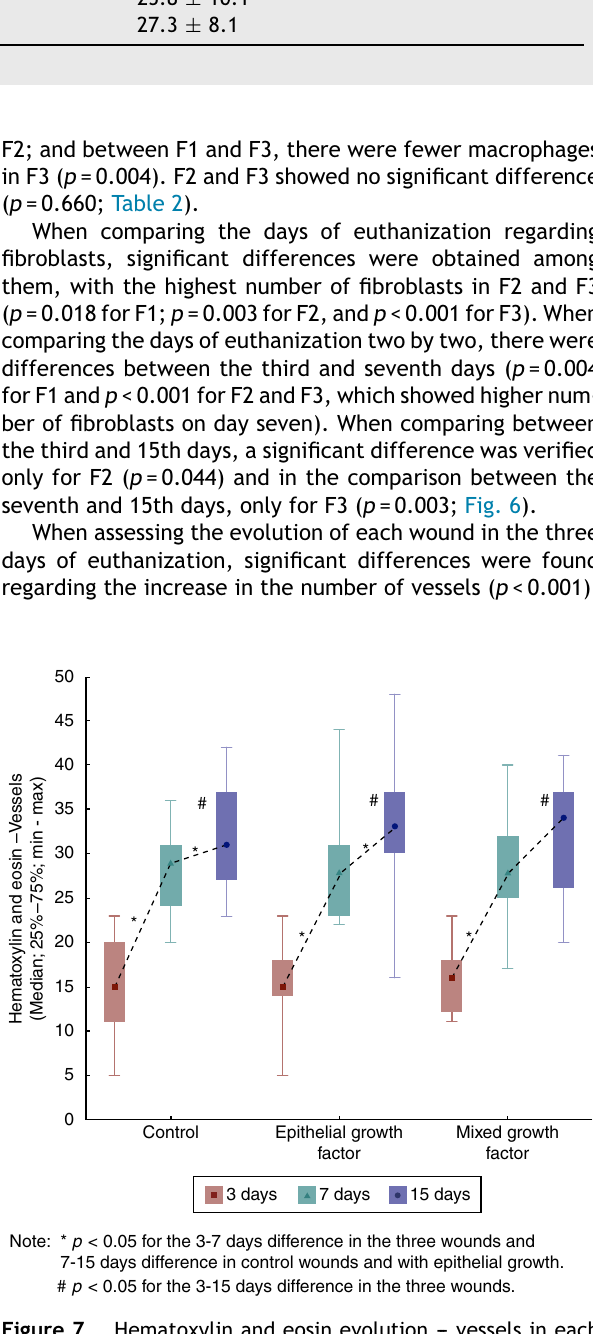
Hematoxylin and eosin evolution --- vessels in each wound, evaluation between the times of euthanization, intra- group